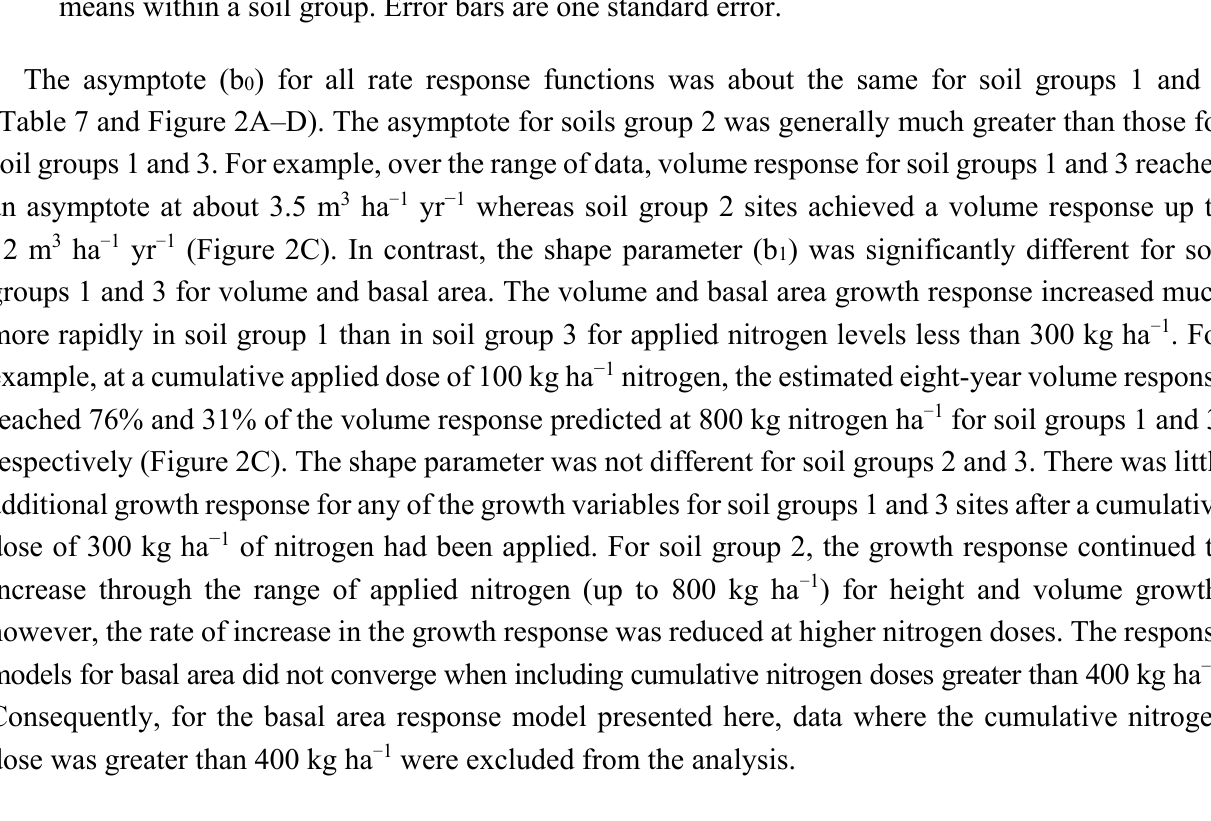
Figure 1. Eight-year average volume growth in soil groups 1, 2 and 3 for eight treatments where nitrogen was applied at different rates and frequencies across 22 sites in the southeastern United States. Different letters indicate significant differences in treatment means within a soil group. Error bars are one standard